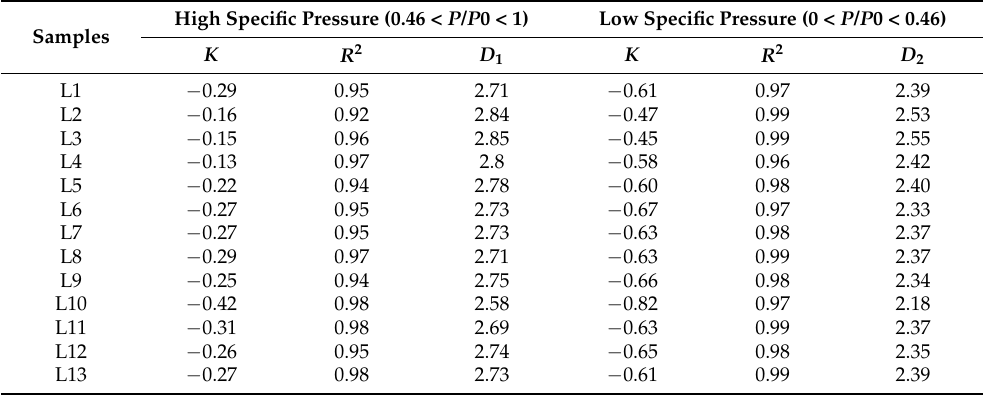
Table 3. Shale pore fractal dimension based on the FHH